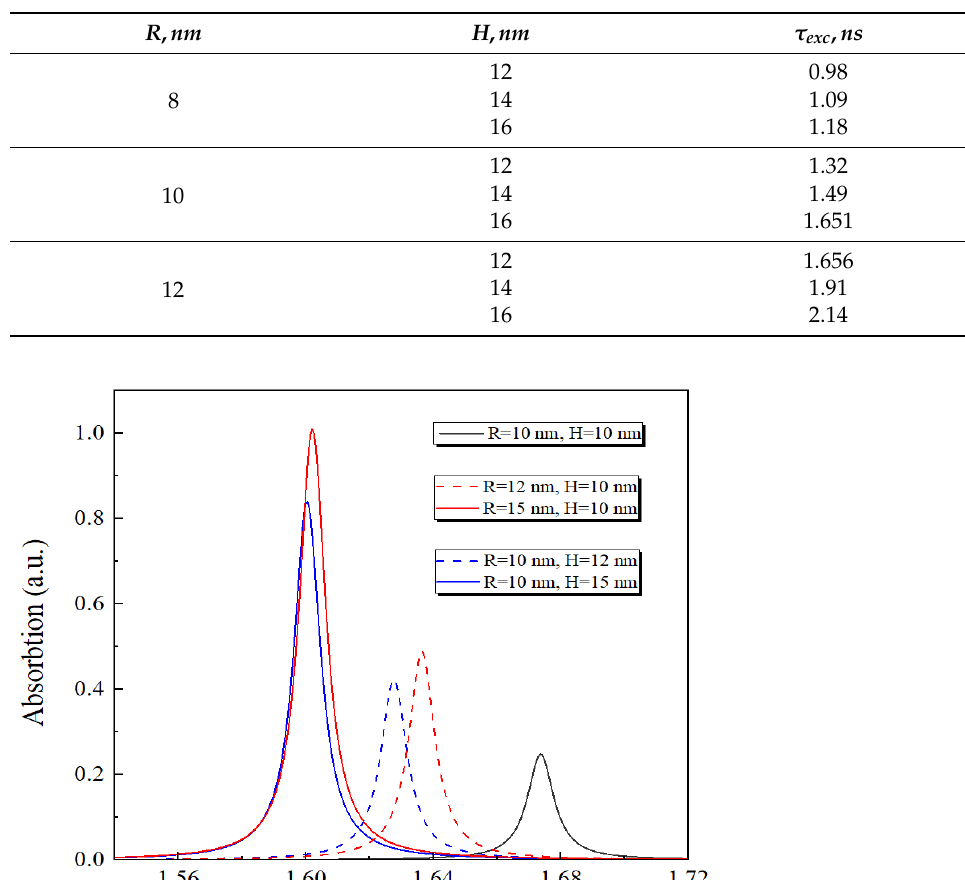
Table 1. Values of the radiative lifetime for the different values of radius and height of the conical QD.